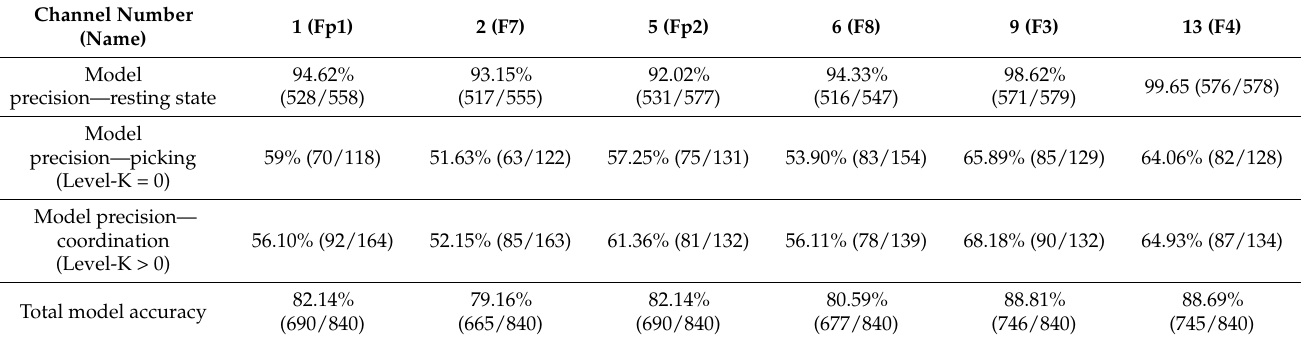
Table 1. Classification accuracy as a function of channel number—VGG16 with symlet6 wavelet. Channel Number (Name)